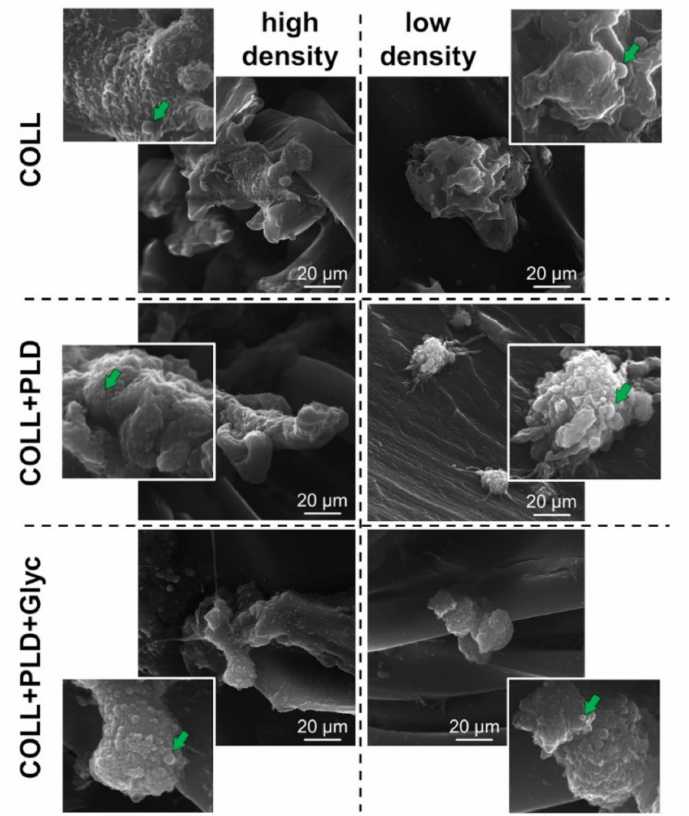
Figure 5. Morphology of the HUVEC cells at sites with high ( left column ) and low ( right column ) density, grown on the Coll ( upper row ), Coll+PLD ( middle row ) and Coll+PLD+Glyc ( bottom row ) prostheses for 4 days—SEM; measurement bars indicate 20 µ m, magnification: 5000 × , green arrows indicate potential extracellular